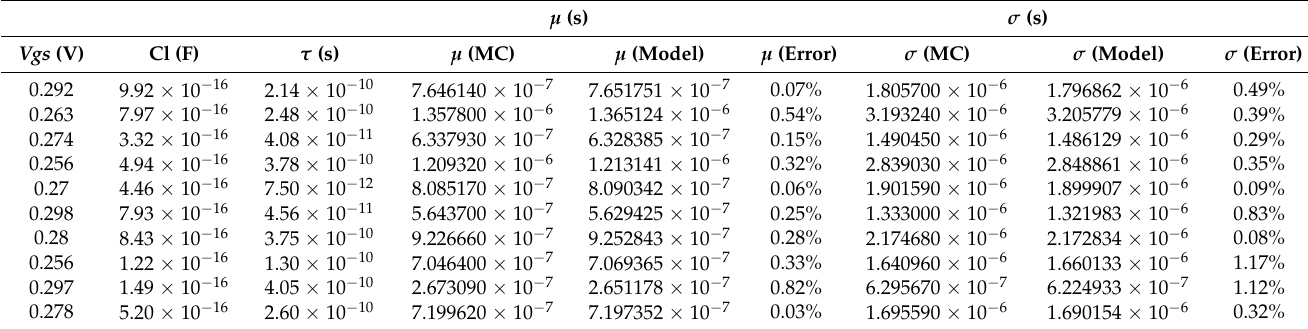
Table 17. Partial data under 28 nm technology (T = 25 ◦ C, Vbs = 0). µ (s) σ